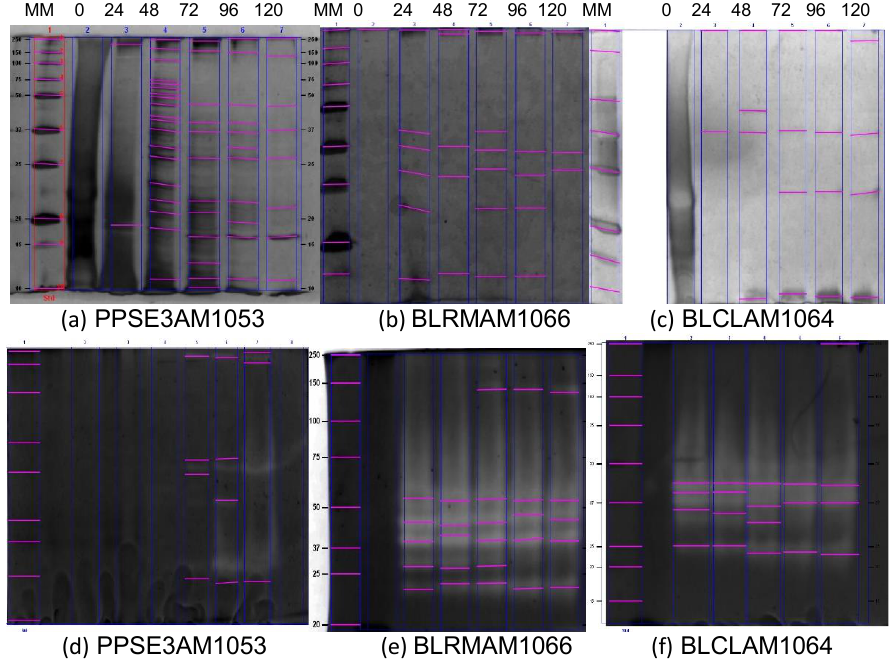
Figure 3: (a,c,e) Electrophoresis of enzymatic extract SDS-PAGE gel at 12%, using silver staining by Chevallet et al . (2006). MM lane molecu- lar weight marker. Figure (b, d, e) zymogram, using 1.5% casein as